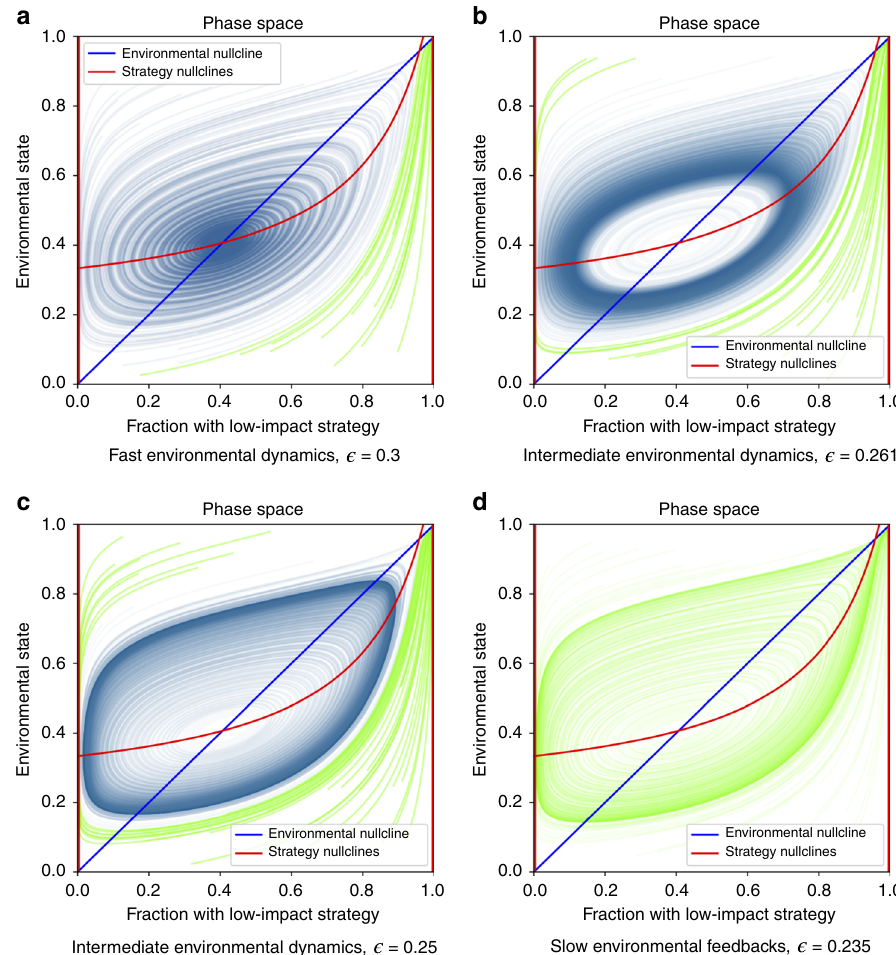
Fig. 4 Simulations of eco-evolutionary game dynamics from the regime with possible cycles in Fig. 2c. In each panel, dynamics proceed in a counterclockwise direction and the color of the solution curves illustrate the basins of attraction. Green curves approach the state dominated by the low- impact strategy, and blue curves represent regions that approach either the interior equilibrium or a stable limit cycle. a System dynamics under fast environmental feedbacks. Here, the interior equilibrium is stable and has a large basin of attraction. b , c Cases with environmental dynamics of intermediate speed exhibit bistability between the low-impact dominated state and limit cycles in the interior of phase space. d Dynamics under slow environmental feedbacks. When feedback speed falls below a critical threshold, limit cycles are no longer possible and the entire phase space approaches the low-impact equilibrium. ( α ¼ 1 ; Δ 1 ¼ (cid:3) 1 = 8 ; δ 0 ¼ 1 ; Δ 1 ¼ 4 ; δ 0 ¼ L H L H Case study 2: grass-legume competition . Evo-evolutionary games